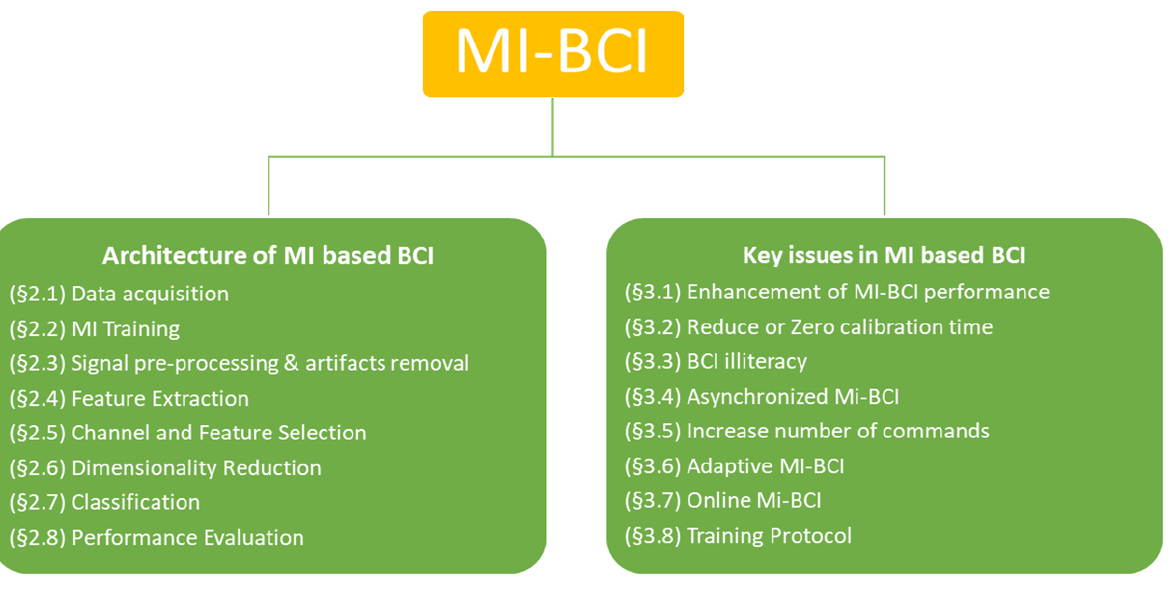
Figure 1. Breakdown of the